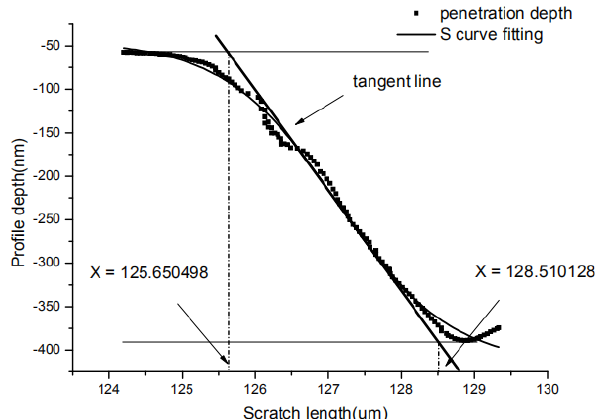
Figure 7: The process of calculating the width of one interface [110]